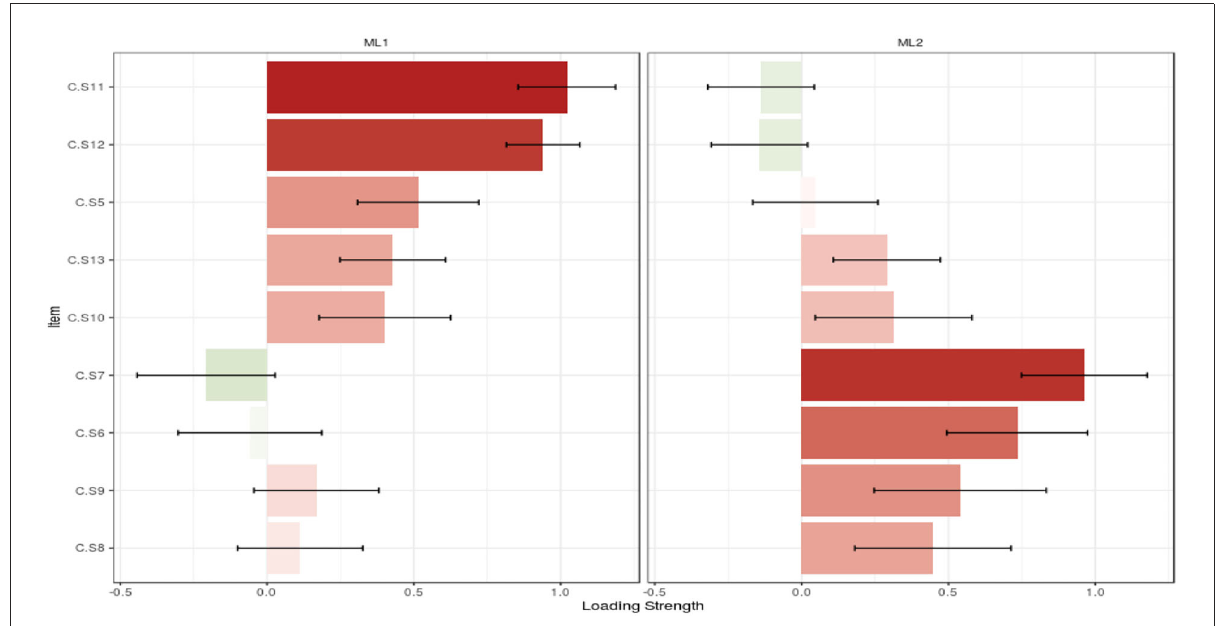
TABLE 4 Fit indices of the CFA model after structure modification of the CCS ( n